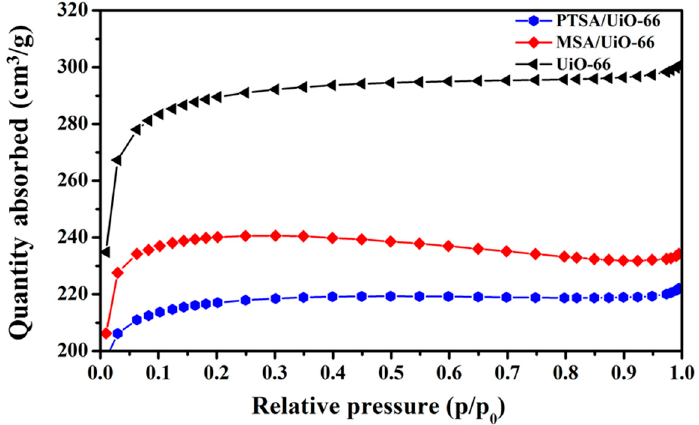
Figure 3. N 2 adsorption-desorption isotherms of UiO-66-supported acids.